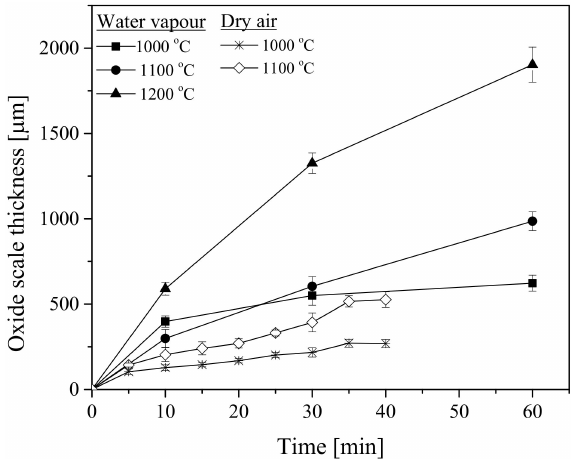
Figure 9. Comparison of the oxide scale thickness as a function of temperature for specimens oxidized under dry and water vapor